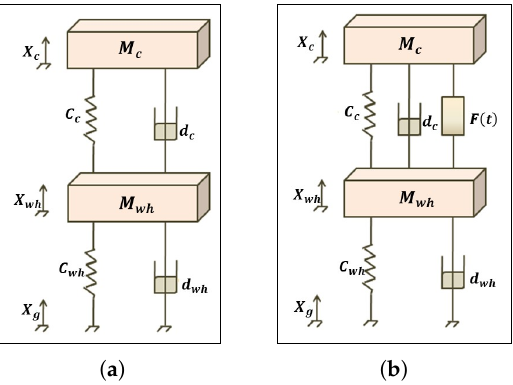
Figure 2. Suspension models of quarter-car ( a ) Passive suspension system ( b ) Active suspension